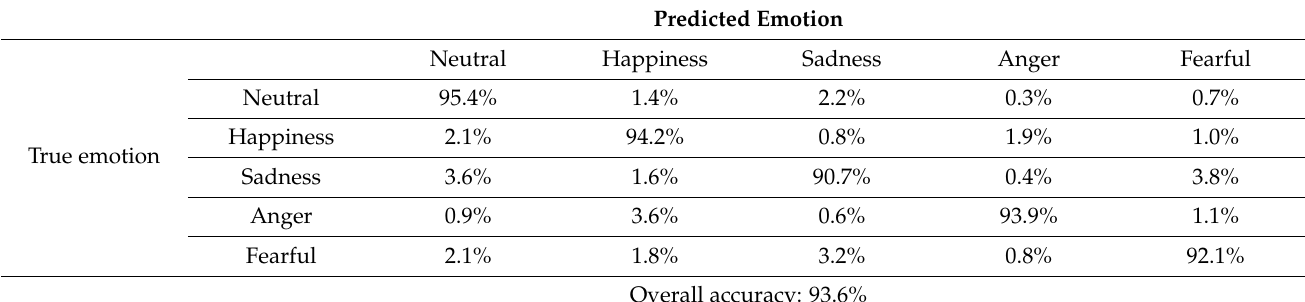
Table 8. Confusion matrix of the emotion classification results of the baseline CNN that was trained on the original Korean CADKES.